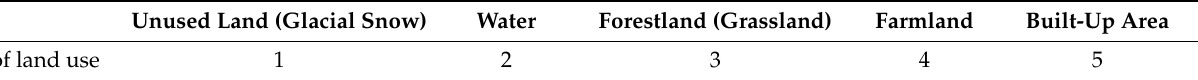
Table 3. Assignment table for land use intensity ratings.